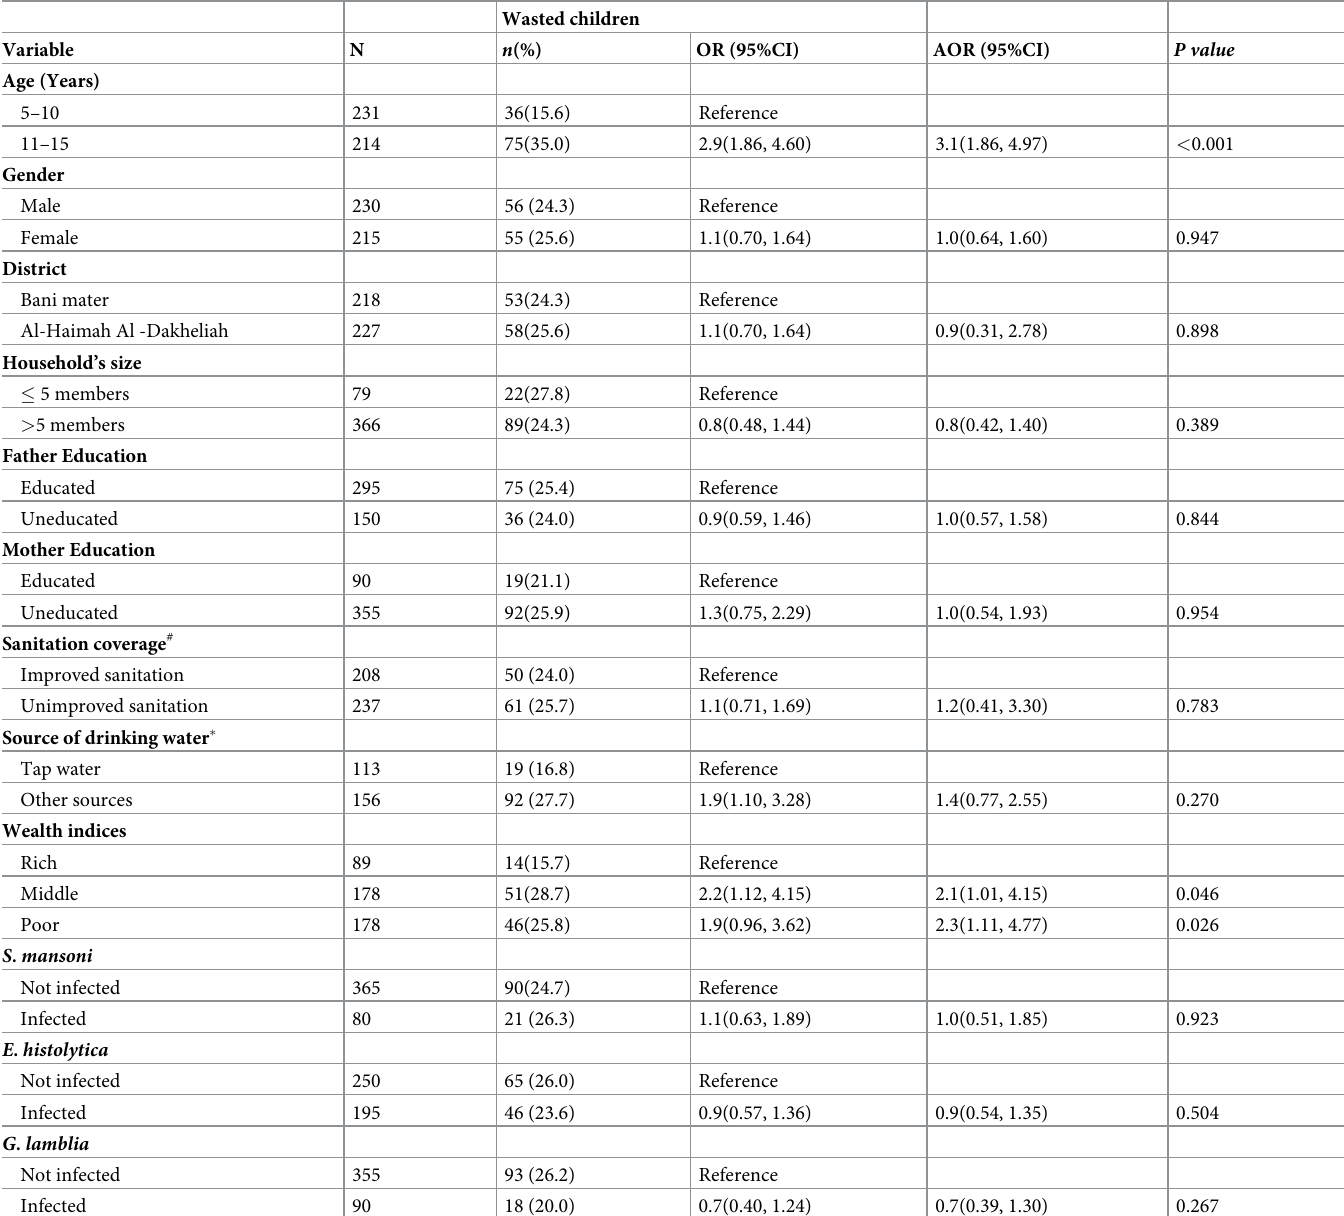
Table 7. Factors associated with wasting among schoolchildren, Sana’a Governorate, Yemen (N =